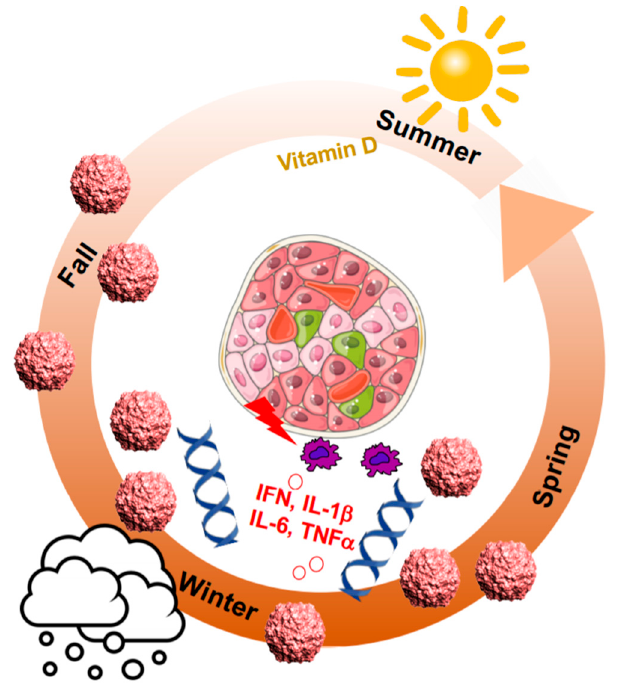
Figure 1. Not only environmental factors but also gene regulation show seasonal patterns. T1D (type 1 diabetes) diagnosis peaks in the colder months of late autumn to early spring, where viral infections come together with less sunlight exposure, less exercise outside, a change in diet together with an increase in pro-inflammatory cytokines and a change towards pro-inflammatory gene networks.